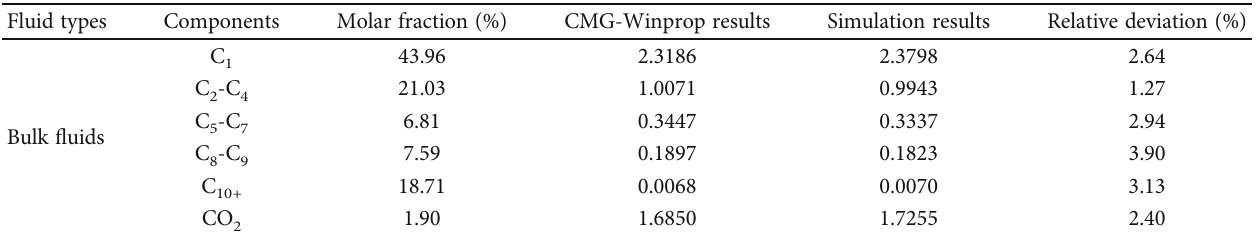
Figure 3: Flow char for phase equilibrium calculation with modi fi ed PR-EOS. Table 1: Comparison of phase equilibrium ratio between predicted results and CMG-Winprop results.